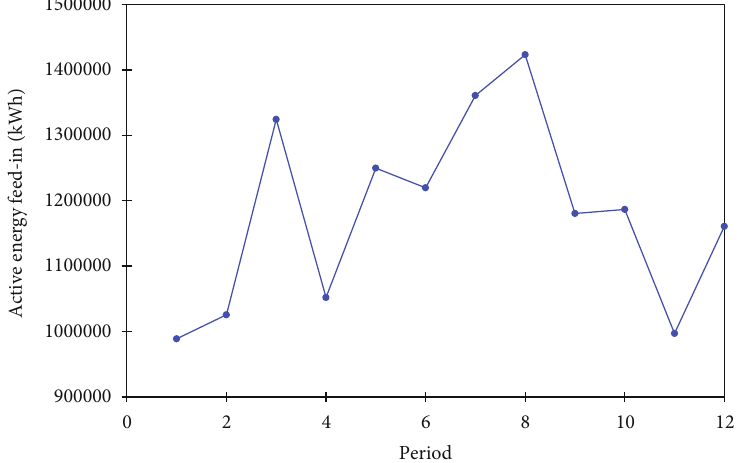
Figure 4: Seasonal Mann-Kendall Trend Test analysis of active kWh energy feed-in in the national grid during